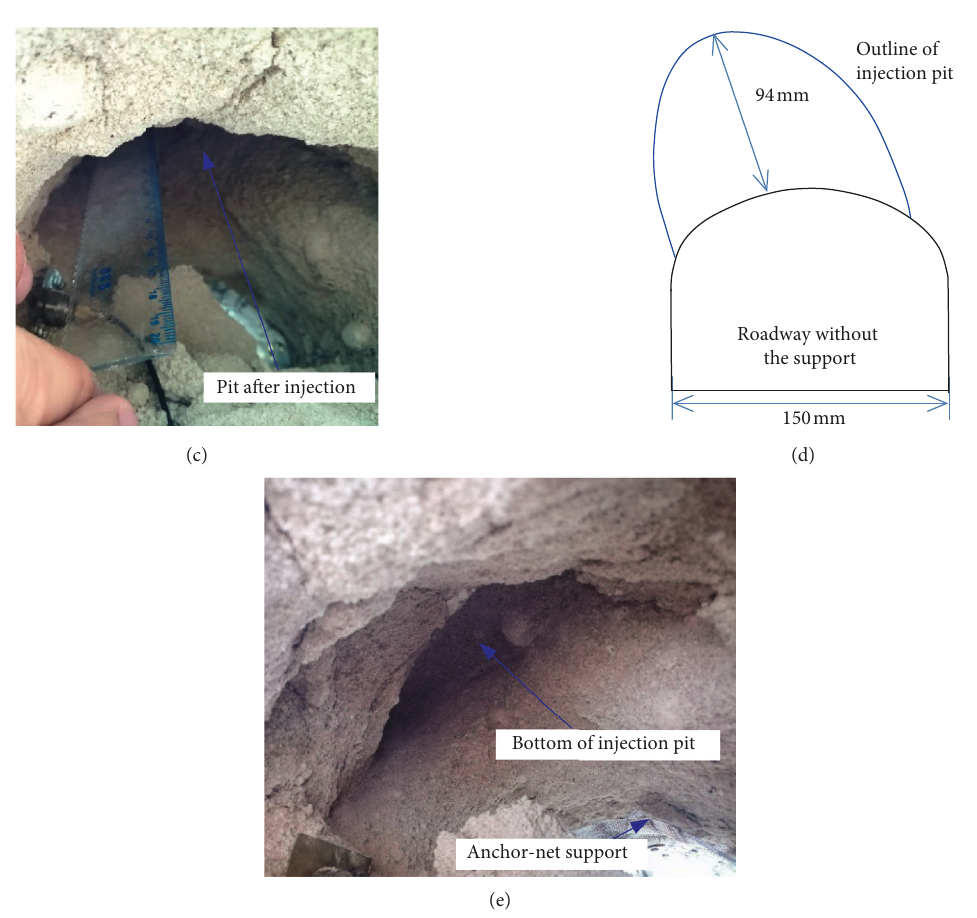
Figure 10: Surface scenes after bursting failure: (a) roadway section with no support, (b) roadway section with the anchor-net support, (c) large pit after the injection, (d) outline of the injection pit, and (e) bottom of the injection